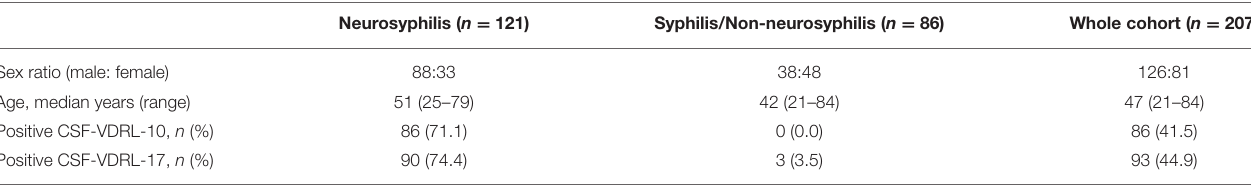
TABLE 1 | Clinical characteristics of the study